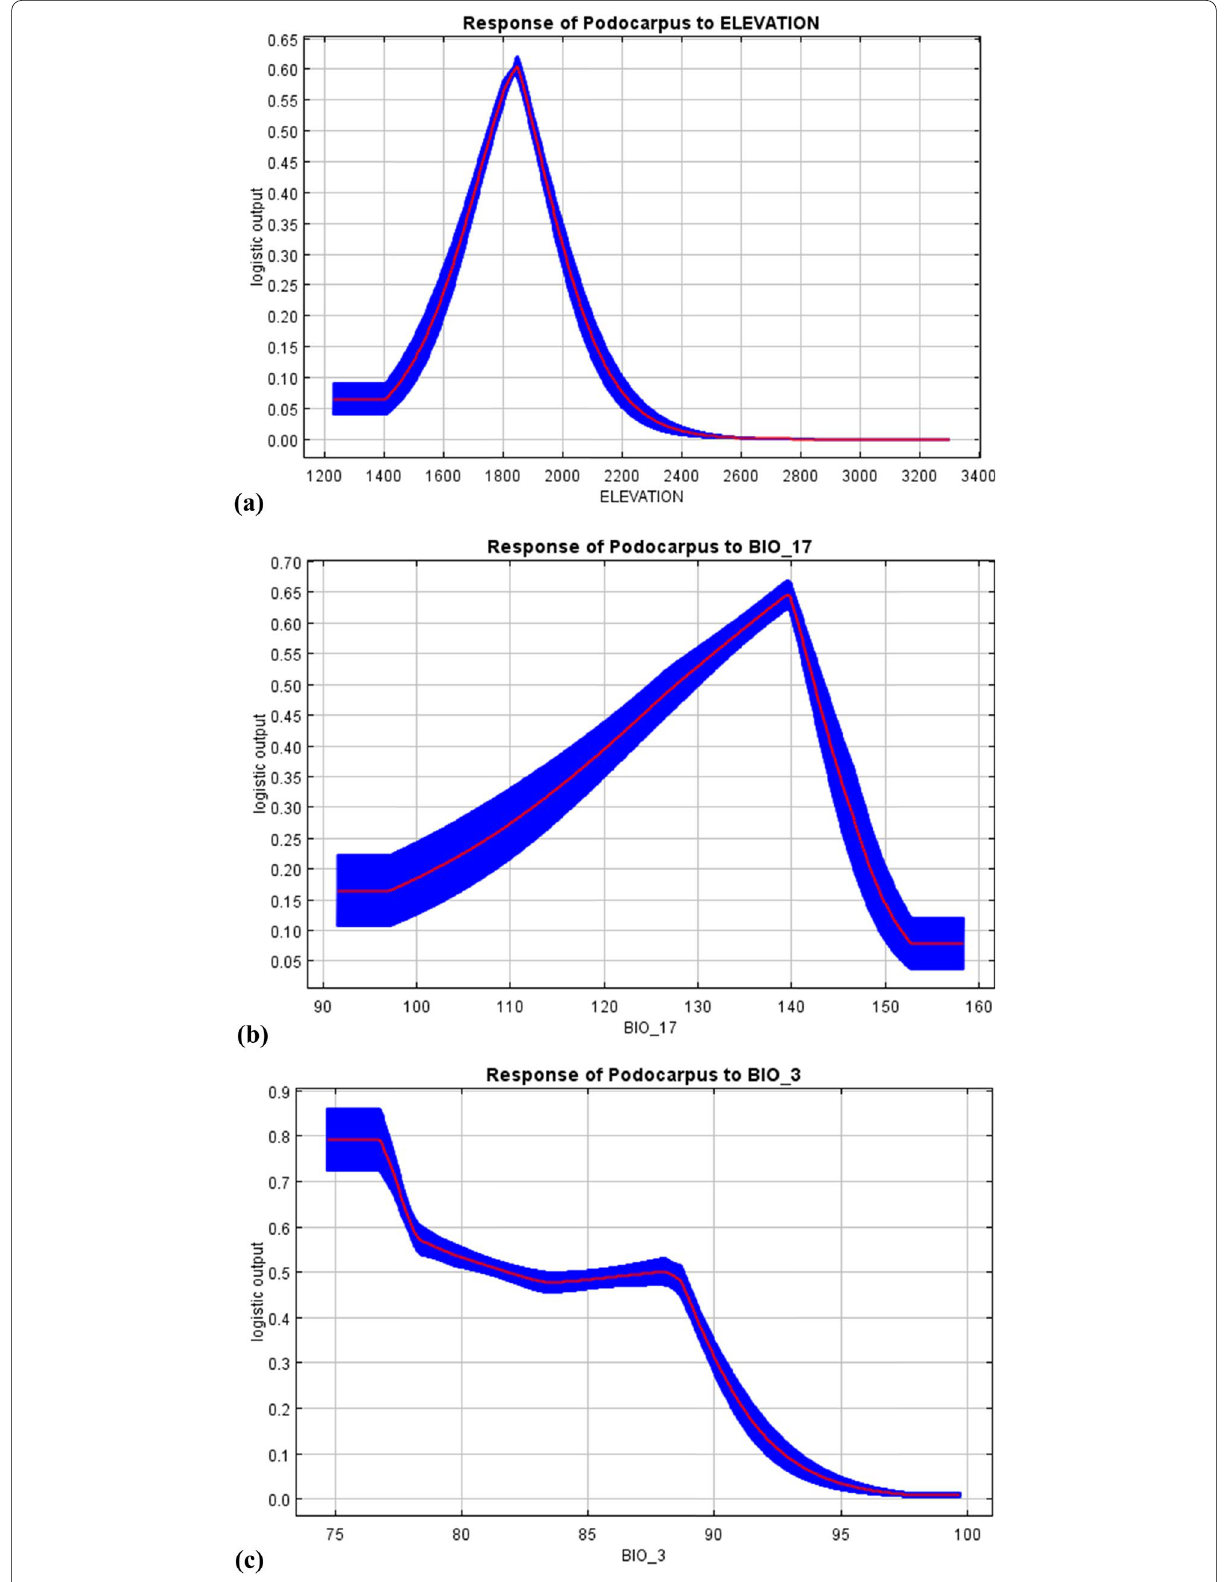
Fig. 5 (See legend on previous